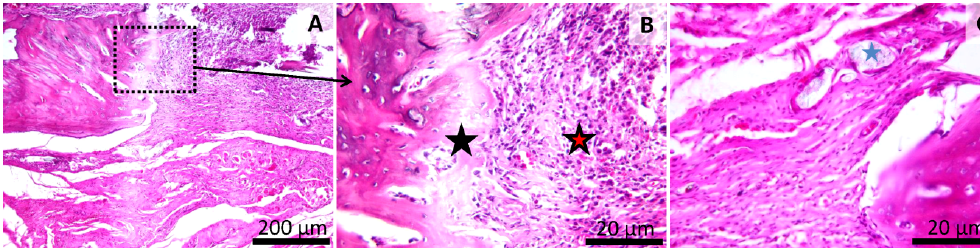
Figure 10. Histology of the mandibular defect. Dental restorative composite group (GZ2) (Group 4). Granulation tissue and fibrous tissue with mononuclear inflammatory cells (red star) ( A ). Area of osteoblastic bone formation (black star) ( B ). Fibrous reaction near the refringent test material (blue star). ( C ) HE stain. Scale bar = 200 μm ( A ), Scale bar = 20 μm ( B , C ).